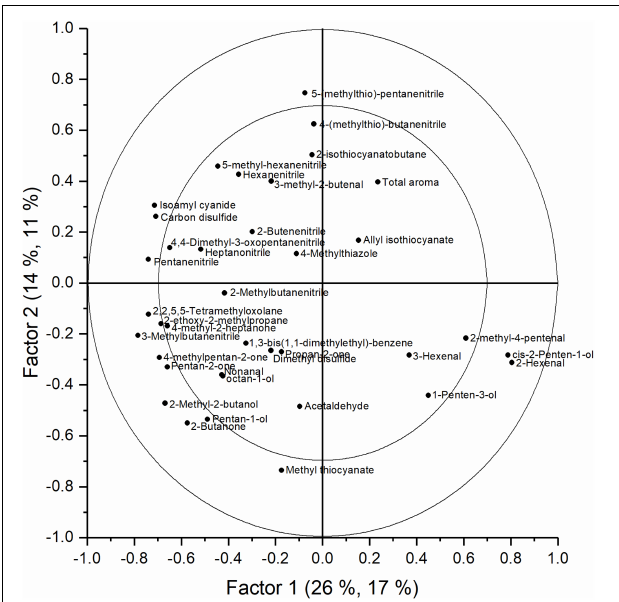
FIGURE 10 | Loadings plot of factor 1 and 3 obtained with the PLS analysis of the aroma measurement of cabbage juices analyzed with SPME-GC-MS.